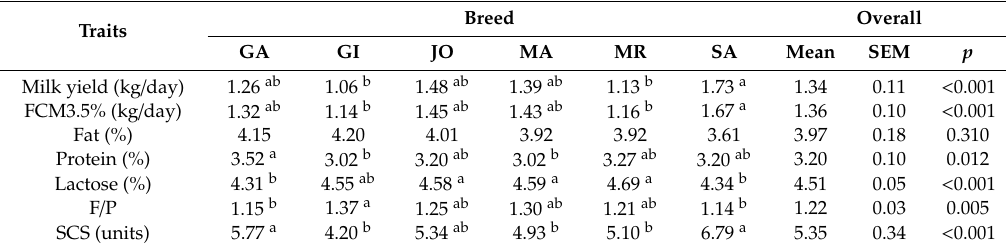
Table 2. Least squares means of milk yield and composition of 6 goat breeds 1